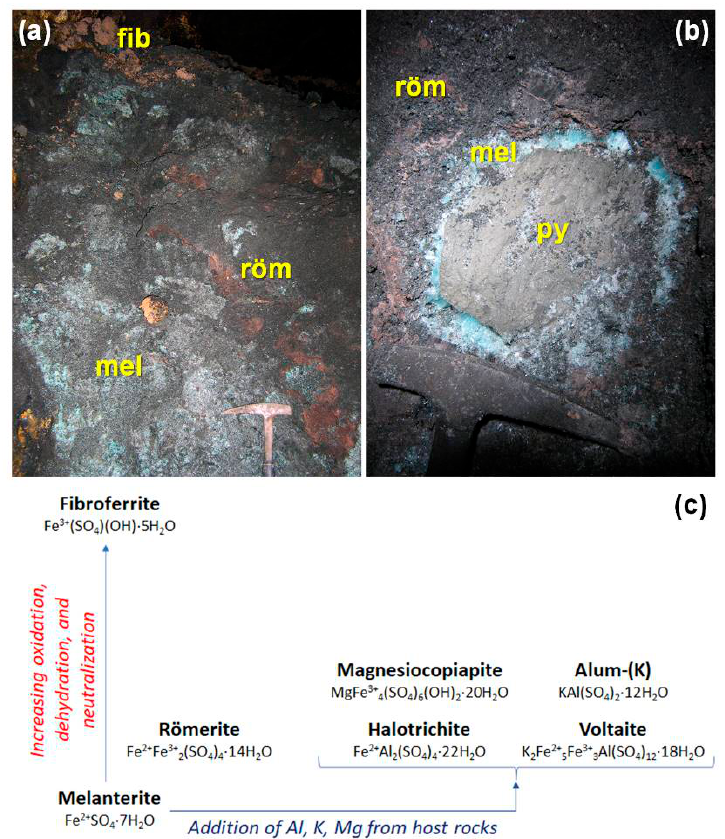
Figure 29. ( a ) Vertical section in the sulfate pile #2 in the Fornovolasco mine, showing, from the core to the rim, the sequence melanterite (mel)—römerite (röm)—fibroferrite (fib); in ( b ), the sequence melanterite-römerite can be observed around unaltered fragments of pyrite (py). An interpretation of the observed sulfate association, limited to the main phases, is given in ( c